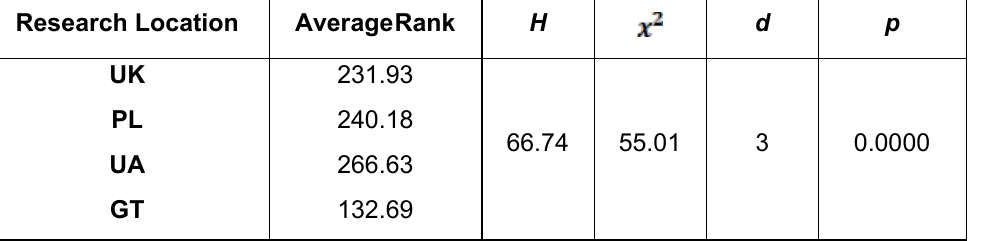
Table 2. Passivity in the studied populations (without strategies division)